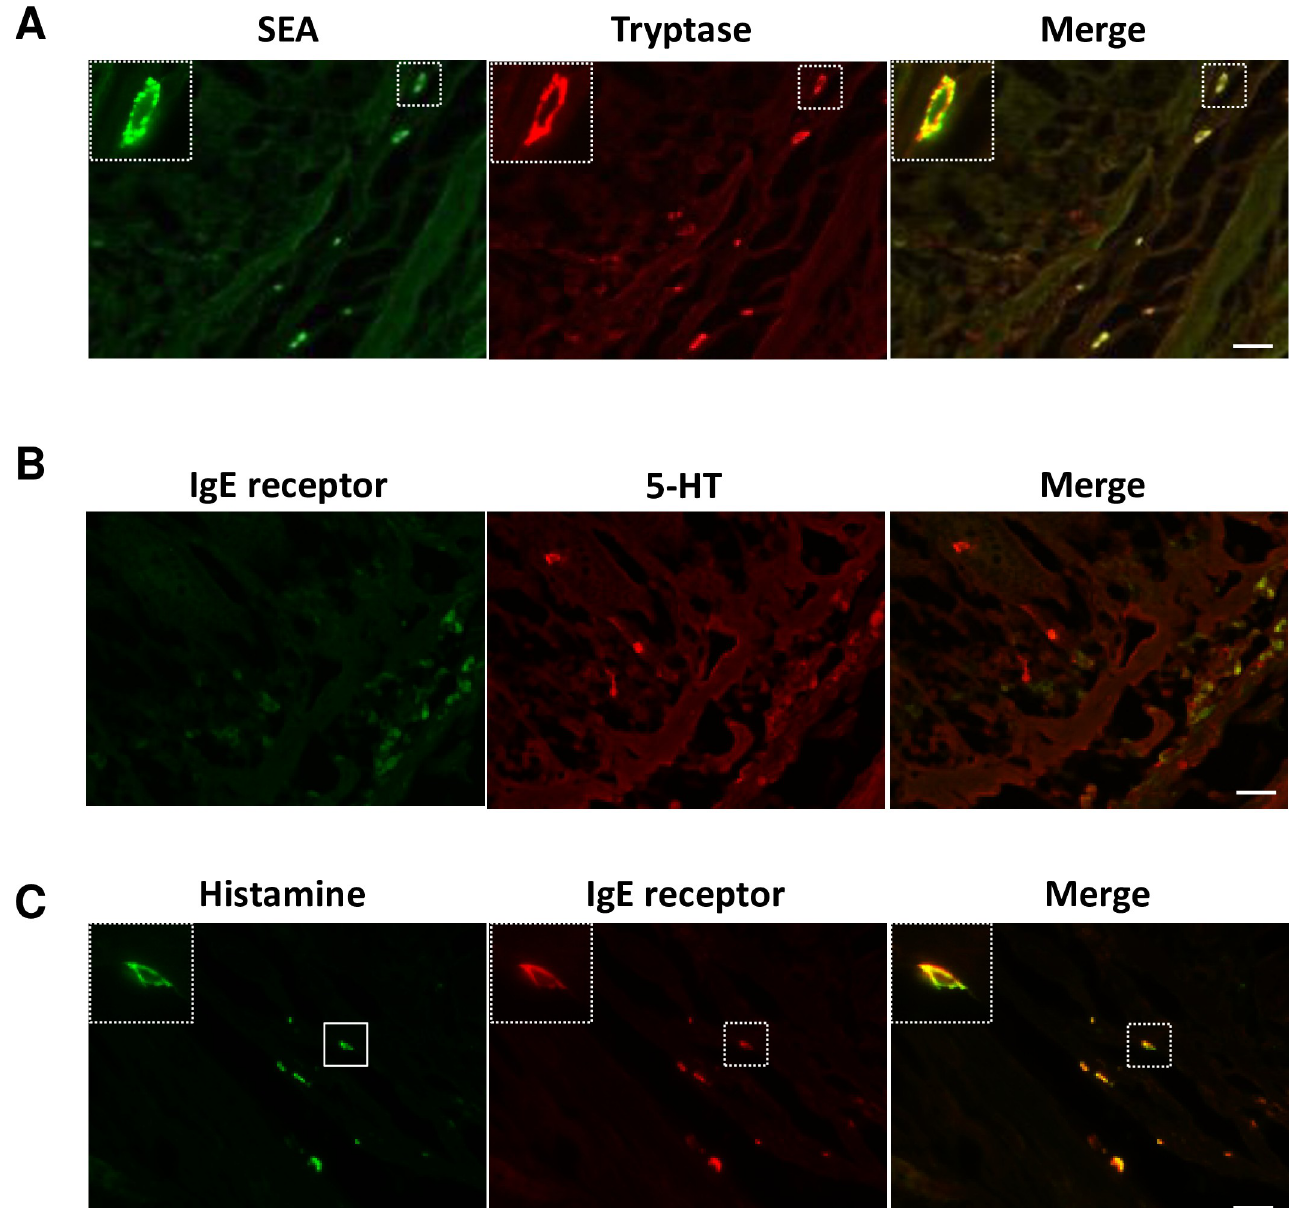
Fig 4. Characterization of SEA-binding mast cells. Specimens of the intestinal tract were removed from a common marmoset. Frozen tissues were sectioned (10 μ m) and incubated with SEA (1.0 μ g/ml) for 60 min at room temperature. (A) Ileal sections were processed for double immunofluorescence staining using anti-SEA antibody (green) and anti-tryptase mAb (red), which recognizes the mast cell marker, tryptase. (B) Ileal sections were processed for double immunofluorescence staining using anti-Fc ε RI α antibody (green) and anti-5-HT antibody (red). (C) Ileal sections were processed for double immunofluorescence staining using anti-histamine antibody (green) and anti-Fc ε RI α antibody (red). Each scale bar is equal to 20 μ m. https://doi.org/10.1371/journal.ppat.1007803.g004 mucosa and submucosa in the GI tract. To estimate the extent of degranulation in the submu- cosal mast cells quantitatively, we compared the number of metachromatic-staining cells in toluidine blue-stained jejunum sections between SEA and phosphate-buffered saline (PBS) injection (Fig 5A). The results revealed that the number of metachromatic cells in the SEA- injected loop significantly was decreased in the jejunum submucosa compared with PBS-